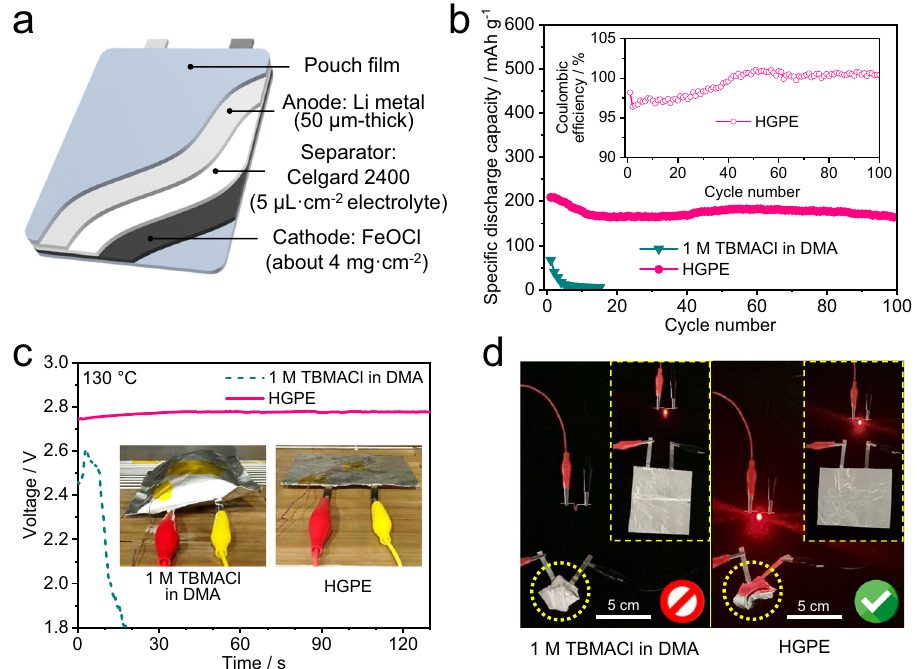
Fig. 6 | Pouch cell characterizations of the quasi-all-solid-state CIB system. a Schematic illustration of Li||FeOCl pouch cells. b Cycling performance of Li|| FeOCl pouch cells with 1M TBMACl in DMA electrolyte and Cl-ion-conducting HGPE at 125mAg – 1 and 25°C. Inset is the Coulombic ef fi ciency. c Open circuit voltage changes of fully charged Li||FeOCl pouch cells with 1M TBMACl in DMA